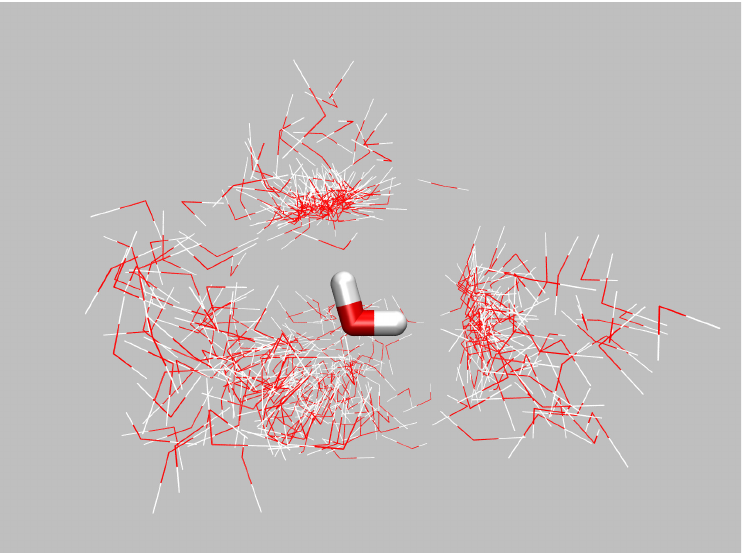
Figure 5. 100 snapshots along a 10 ns trajectory of the molecules matched to the four molecules closest to the fixed water in the reference snapshot. Oxygen atoms are shown in red and hydrogen atoms in white.